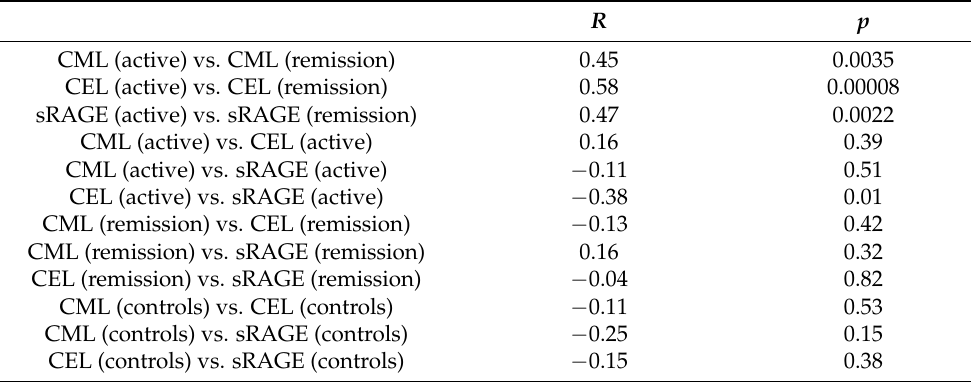
Table 3. Correlations between the evaluated